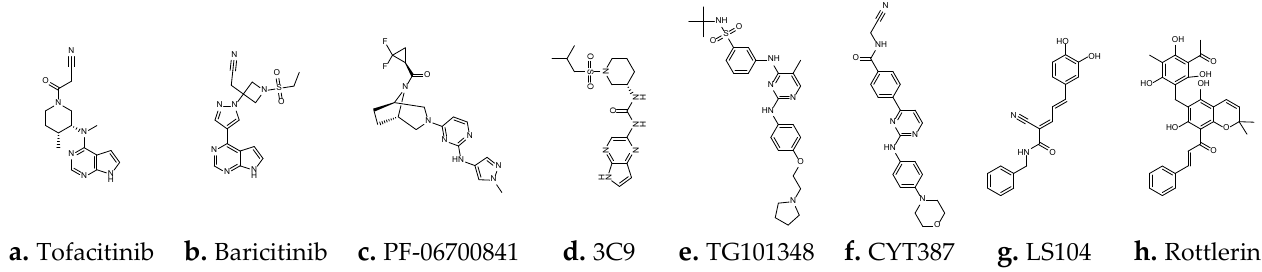
Figure 1. A series of JAK inhibitors.